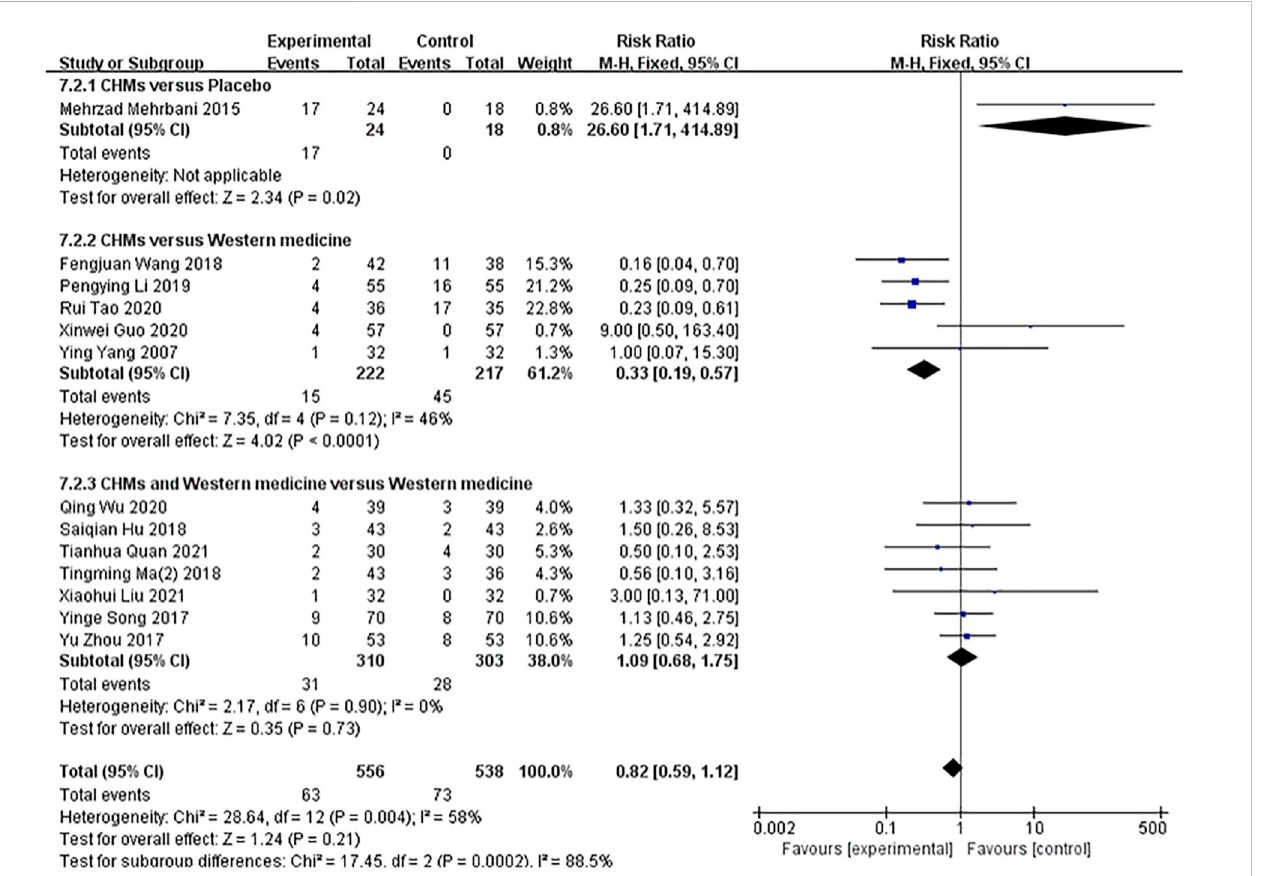
FIGURE 10 Theresultsofthemeta-analysisfortheeffectofChineseherbalmedicine(CHM)oracombinationofCHMandWesternmedicine(WM)versusWMonthe rate of adverse